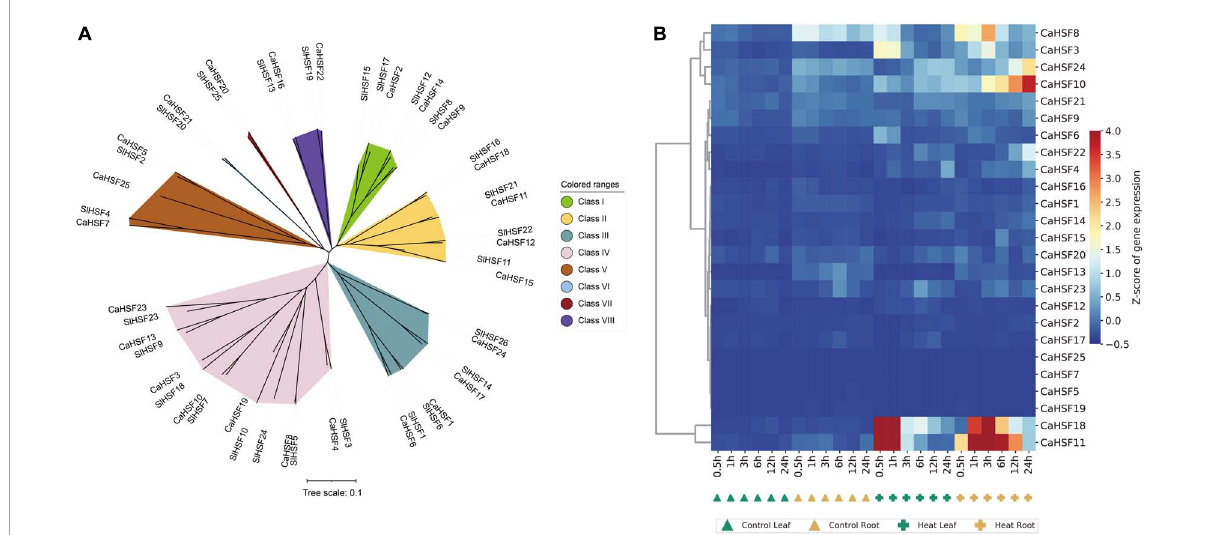
FIGURE9 Phylogeny and gene expression of HSFs. (A) Phylogenetic analysis of tomato and pepper HSF proteins shows that they can be grouped into eight classes. (B) Heatmap showing the temporospatial expression of CaHSFs.